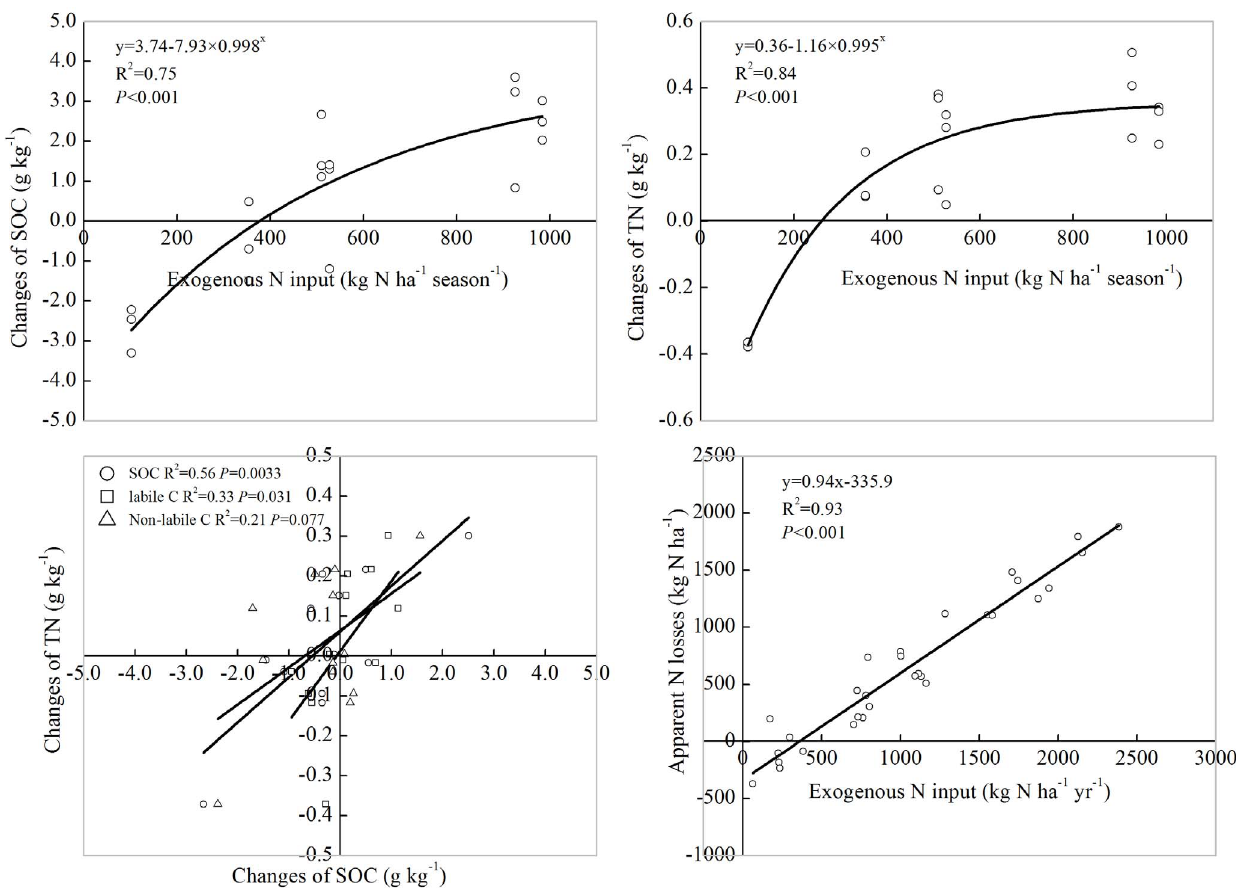
Figure 5. The relationship between the changes in SOC and TN concentration after 6 years of cultivation, as well as annual apparent N losses and the average N inputs in the year-round greenhouse tomato planting system in Shouguang, northern